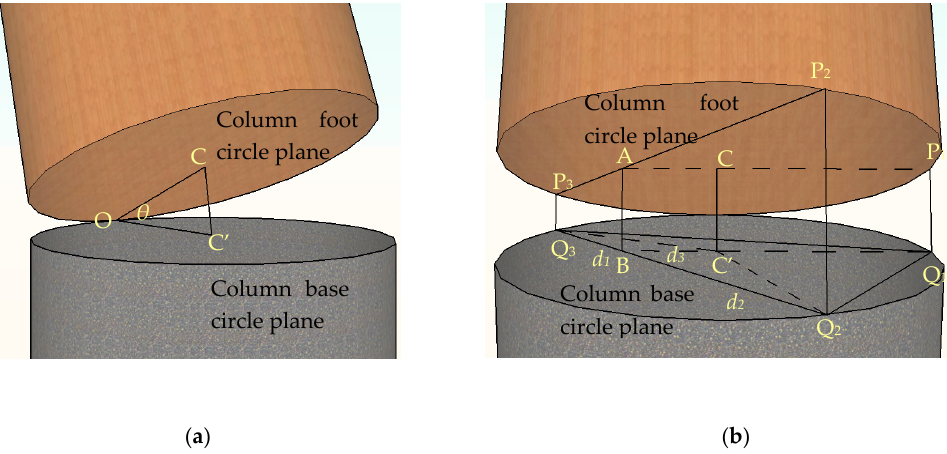
Figure 5. Analytical sketch of inclination angle: ( a ) Calculation diagram of inclination angle θ ; ( b ) Calculation diagram of l CC’ .